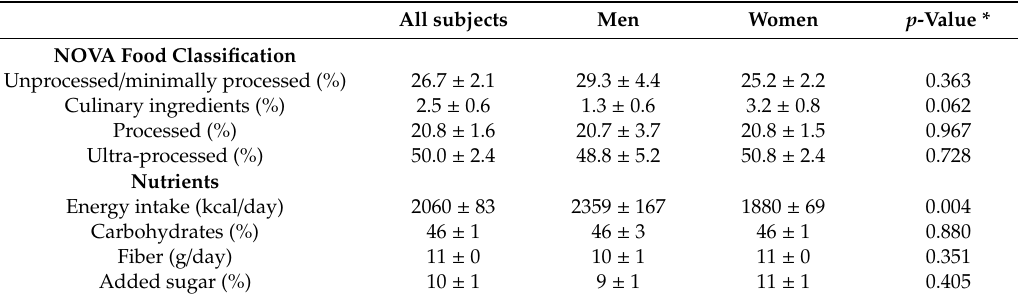
Table 3. Habitual dietary intake from 3-day food